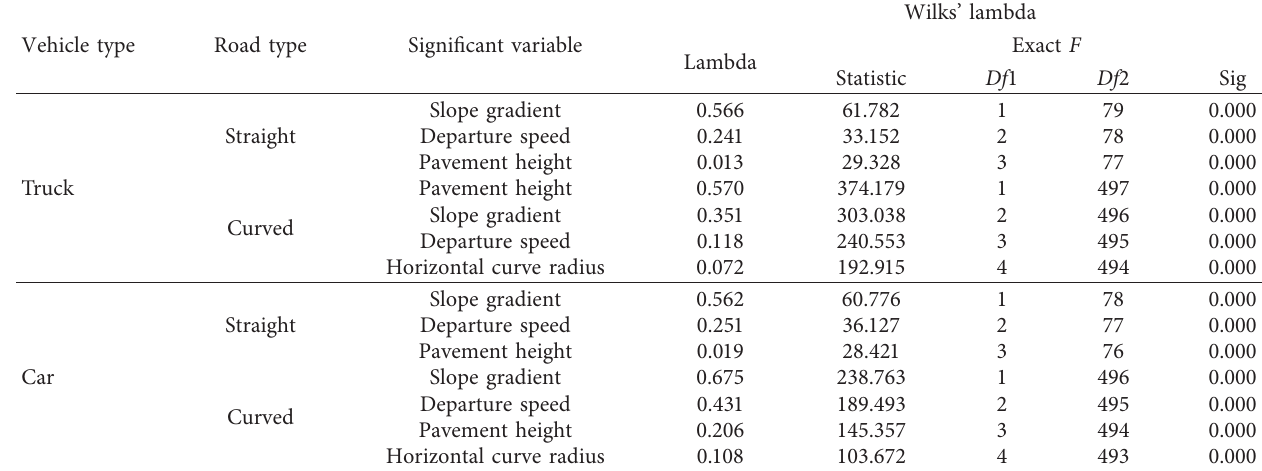
Table 5: Enter/delete